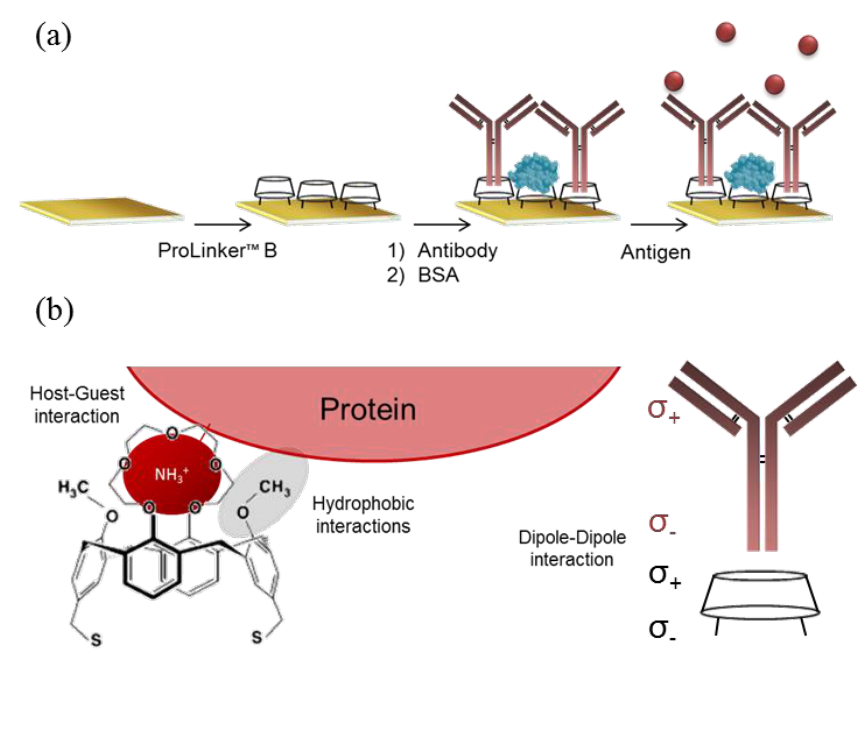
Figure 1. ProLinker™ strategy ( a ) Immobilization protocol: (i) surface coating